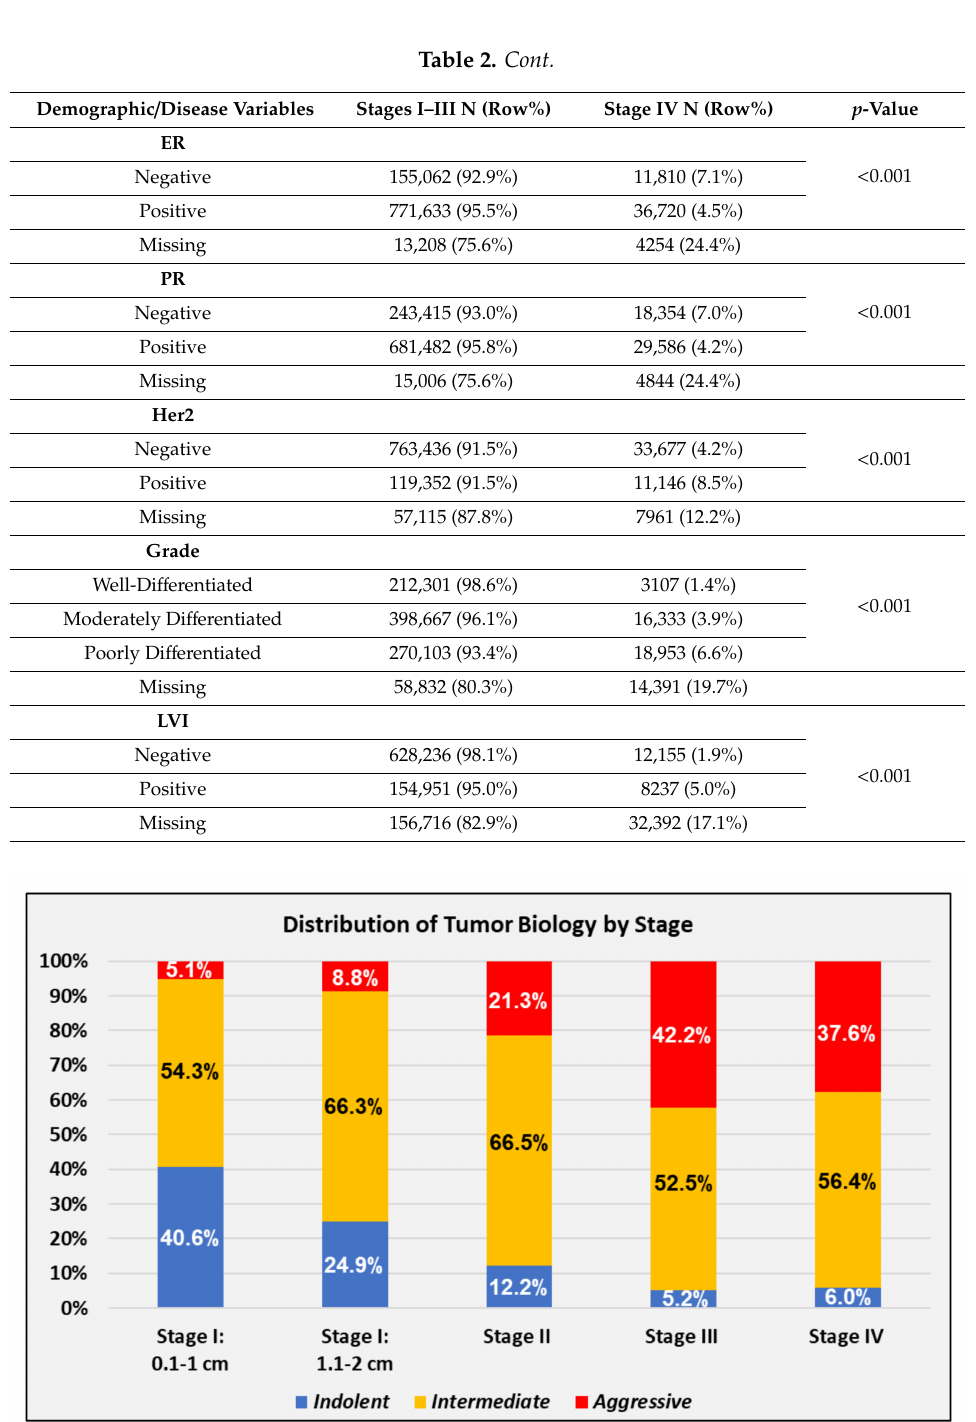
Figure 2. Tumor biology by AJCC 7th edition